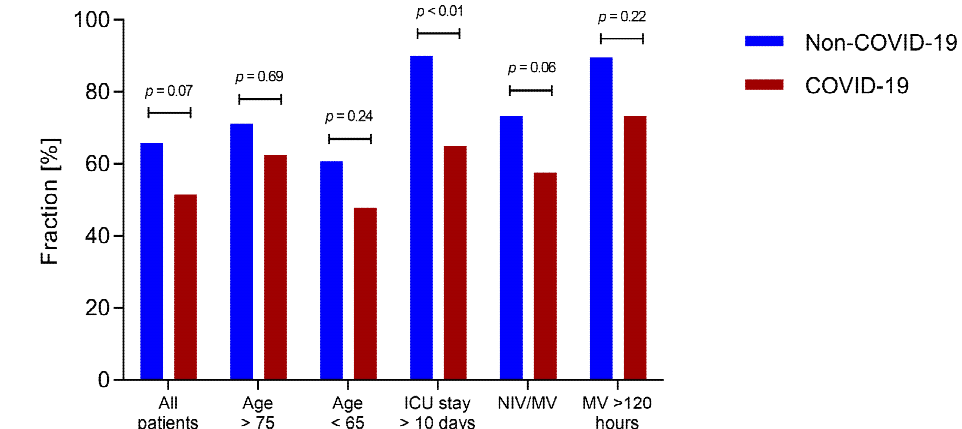
Figure 2. Duration of stay on the ICU. Graph showing ICU stay of all patients included, separated by the presence of COVID-19 and incidence of delirium.